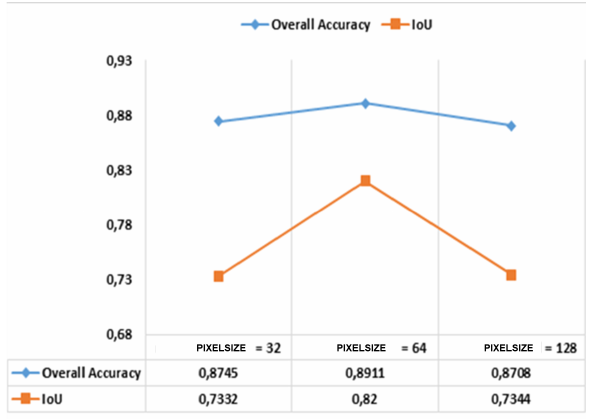
Figure 11. Sensitivity of the number of pixels to be sampled on the model performance